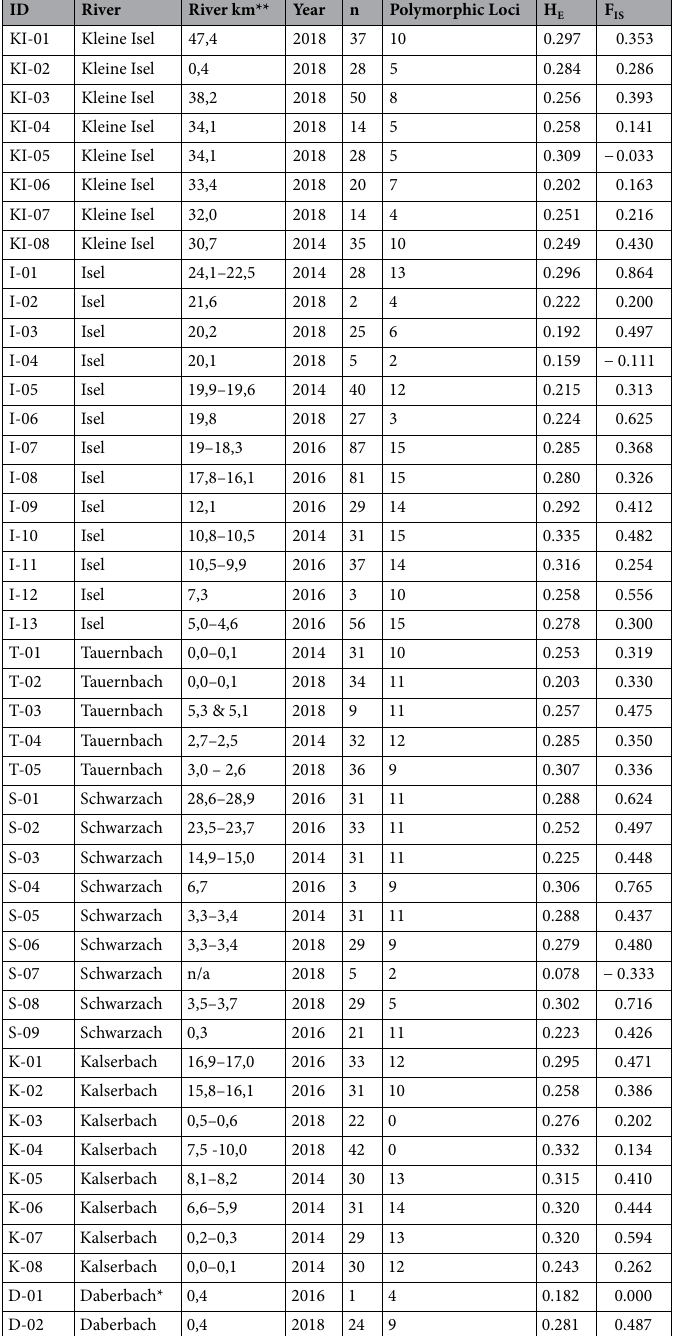
Table 1. Overview of sampling sites in the years 2014 to 2018, and number of samples (n), polymorphic loci, expected heterozygosity (H E ) per site and inbreeding coefficient of populations (F IS ). **River kilometer according to the Austrian riverine network (Berichtsgewässernetz, https:// maps. wisa. bmlrt. gv. at/). *Small tributary to Isel in the downstram area, analysed as part of the Isel river